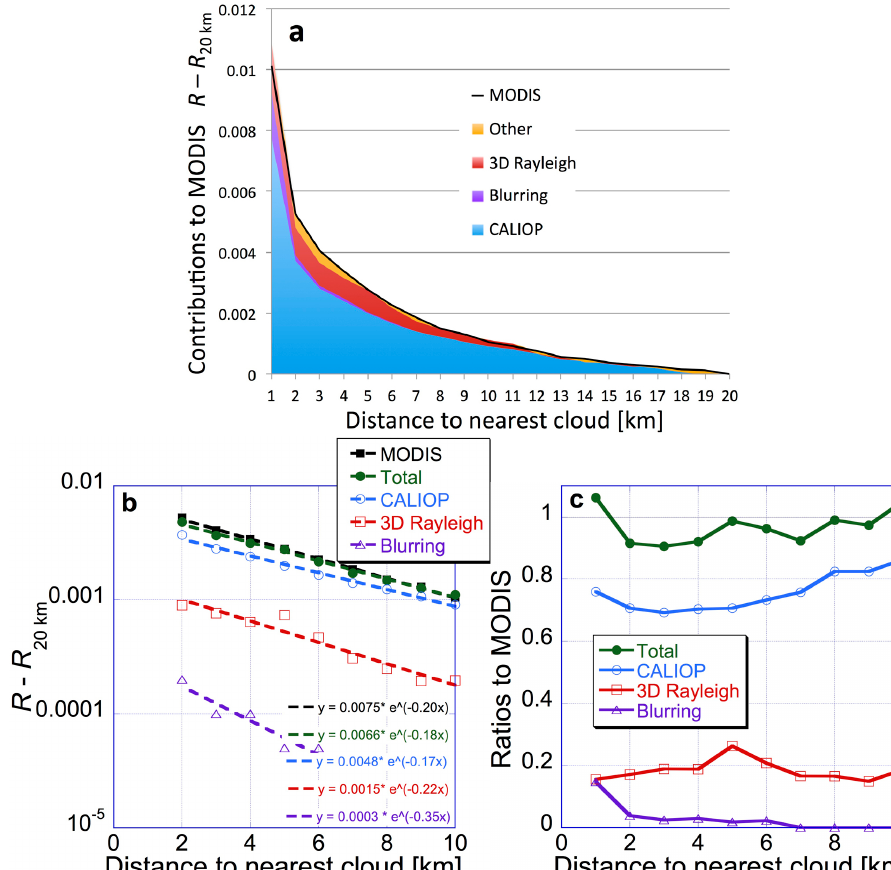
Fig. 6. Estimated contribution of various factors to the observed near-cloud increase in median MODIS 0.55µm reflectances (black line). The increase is defined as the difference from the median value observed 20km away from clouds. (a) Blue (CALIOP): changes in particle populations, including both aerosol changes such as swelling and changes in undetected cloud particles. Purple (Blurring): instrument blur- ring. Red (3-D Rayleigh): the part of 3-D bluing enhancement that involves cloud scattering in overcast cloud interior pixels and subsequent Rayleigh scattering in clear air. Orange (Other): contributions not yet attributed to a specific process, including 3-D enhancements involving cloud scattering near cloud edges, aerosol scattering, and surface reflection. (b) Contributions of various factors on a logarithmic scale. The data labeled “Total” shows the sum of CALIOP, 3-D Rayleigh, and PSF contributions. The dashed lines and equations indicate logarithmic fits; the correlation coefficients ( R) exceed 0.95. (c) Ratio of enhancements attributed to various factors and the enhancements observed by